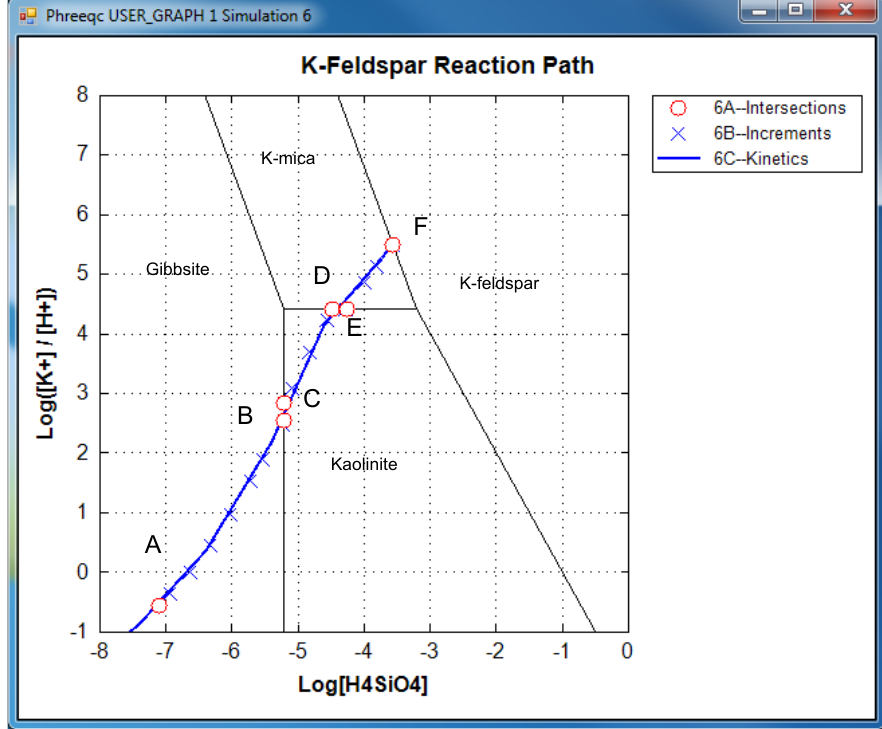
Figure 7. Phase diagram for the dissolution of K-feldspar (microcline) in pure water at 25 o C showing stable phase-boundary intersections (example 6A) and reaction paths across stability fields (simulations 6B and 6C). Phase boundaries are plotted by using thermodynamic data from Robie and others (1978). (Names of the stability fields and letter designations of points have been added to clarify the